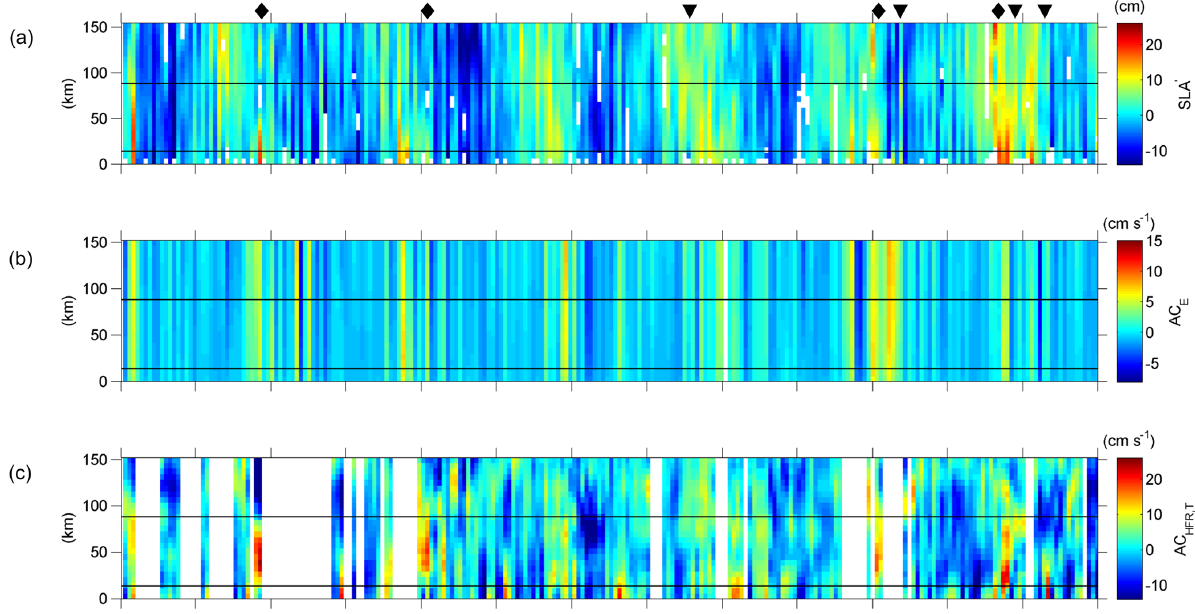
Figure 6. Time evolution from 1 January 2009 to 1 July 2015 along track 248 ( y axis shows distance to the first point of the track in kilo- metres) of (a) CMEMS SLA (cid:48) (cm), (b) AC E (cms − 1 ), and (c) AC HFR (cms − 1 ). The distance from the first point of the track to the coast is around 6km. The horizontal black lines delimit the slope area between the 200 and 1000m isobaths. The black diamonds depict the IPC intensification signals whereas the black inverted triangles show the eddy events, all mentioned in the text.